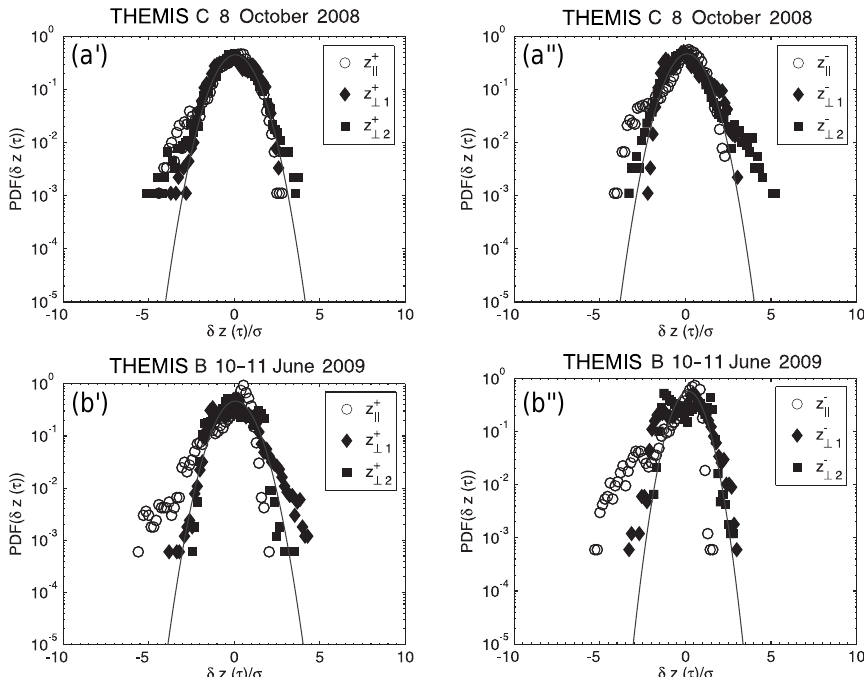
Figure 12. The probability density functions (PDFs) of the increments of the parallel (white circles) and two perpendicular (black diamonds and squares) components of the Elsässer variables, δ z + (a’, b’) and δ z − (a”, b”), for a given timescale τ = 9s, near the bow shock (cases (a) and (b) in Table 2).